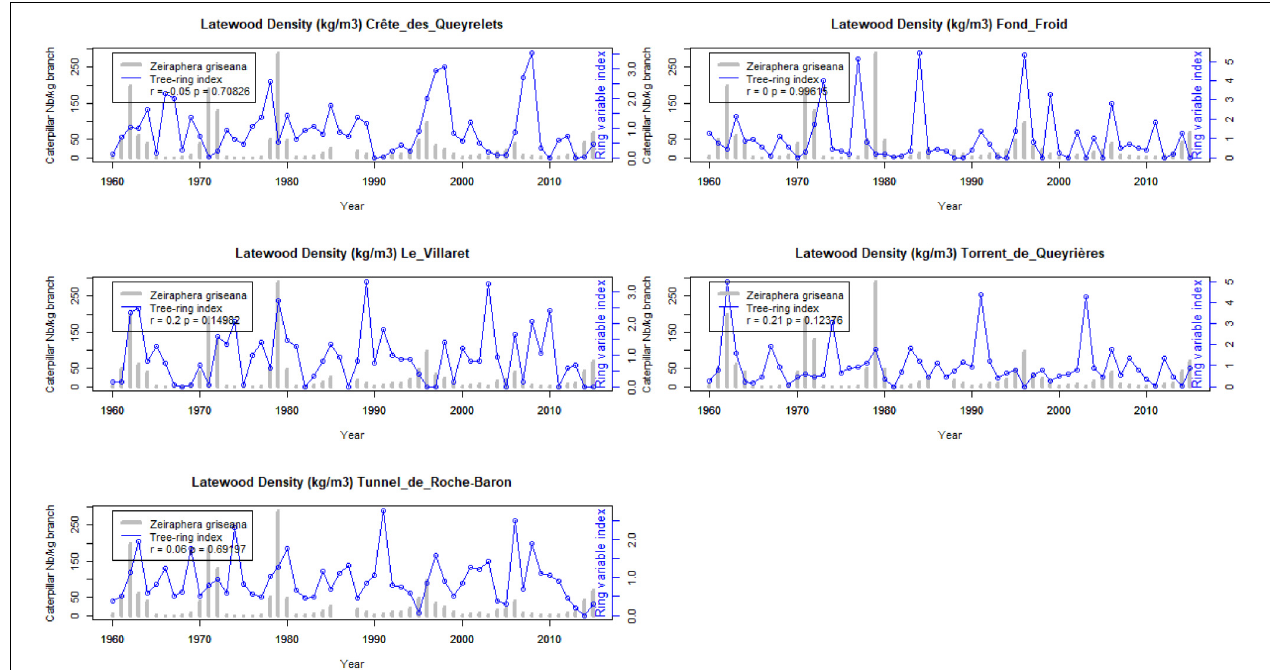
FIGURE 8 | Latewood density time-series of outbreaks reconstruction index from 1960 to 2016 at five plots, two high elevation (Crête des Queyrelets and Fond Froid, approximately 2350 m.a.s.l.) and three low elevation (Le Villaret, Torrent de Queyrières and Tunnel de Roche Baron, approximately 1200 m.a.s.l.). Reconstructed LBM outbreaks (blue lines) and direct observations at Les Combes (gray